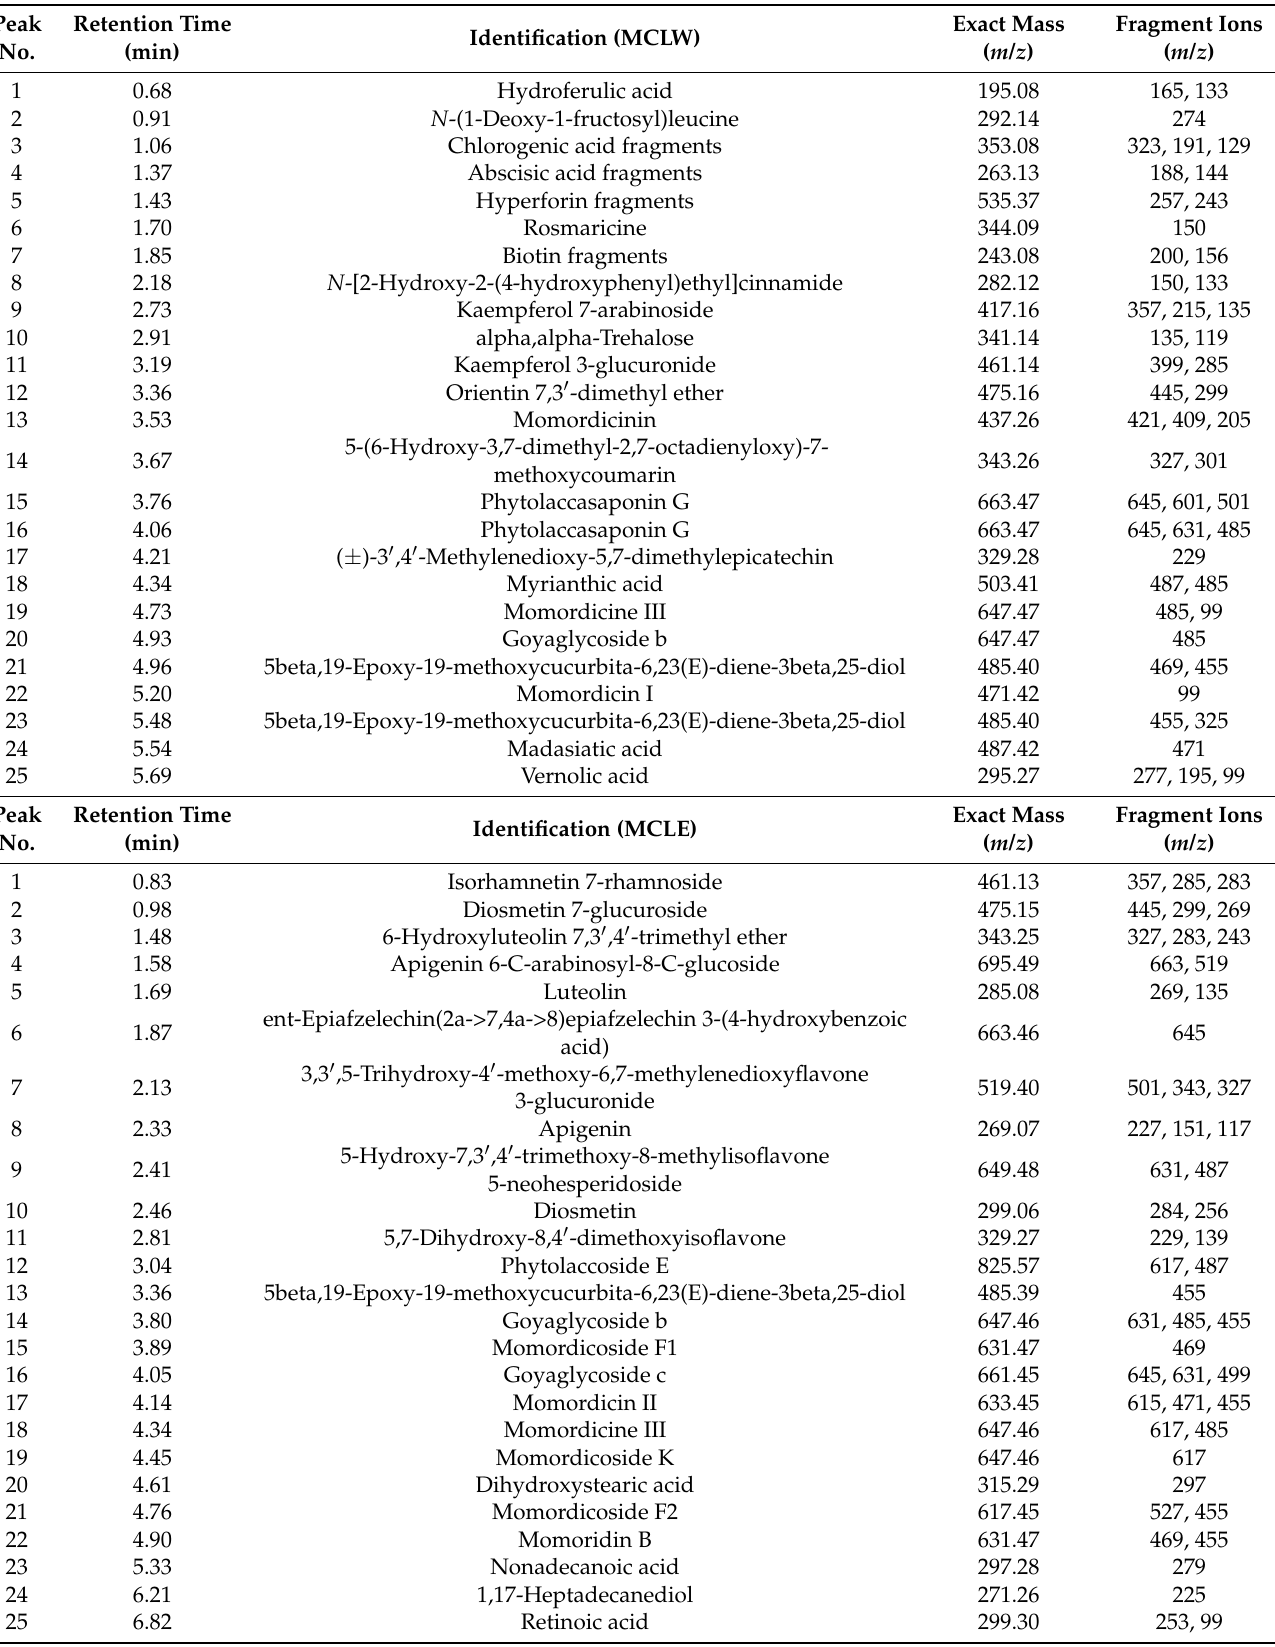
Table 1. List of biomarkers to discriminate MCLW, MCLE, and